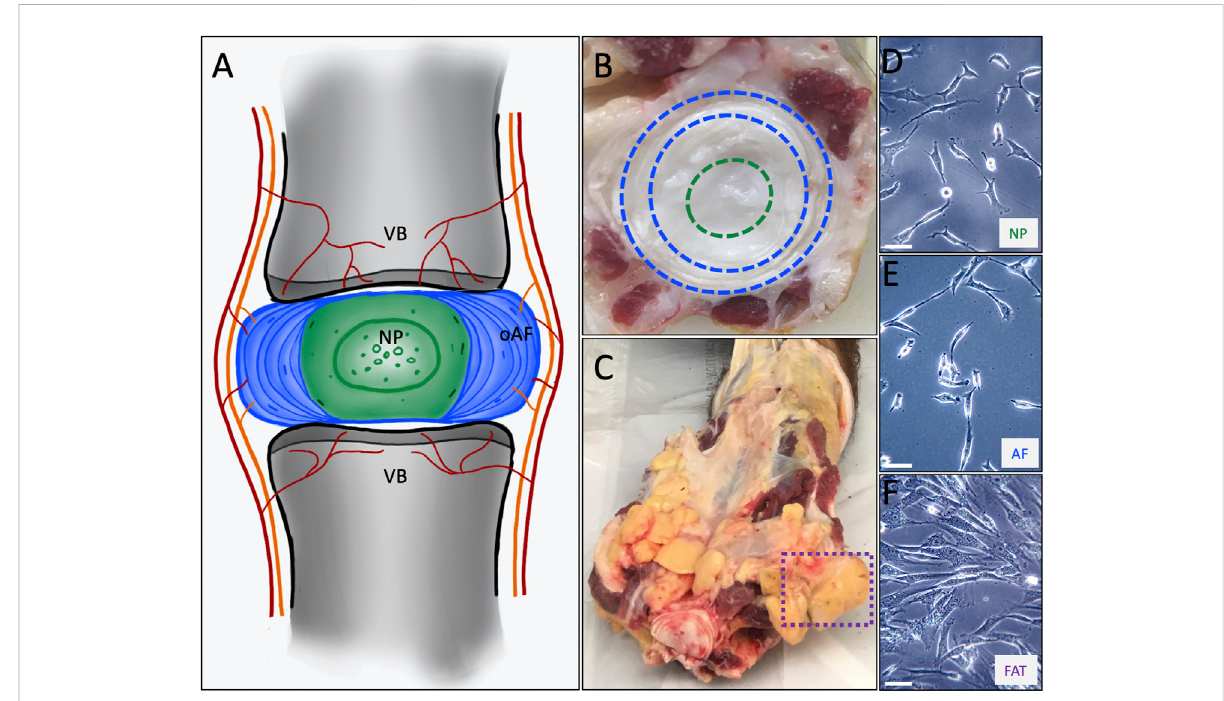
FIGURE 1 (A) Schematic representing the intervertebral disc consisting of an outer annulus fi brosus (oAF) and inner nucleus pulposus (NP) sandwiched between the cartilaginous endplates of the adjacent vertebral bodies (VB). (B) A cut through a bovine tail showing a coccygeal IVD. The outer AF as seenbetweenthebluedashedlinesandtheNPwithin thegreendashedcircle servedastissue sourceto deriveAF andNPcelllines. (C) Theboxwith thedashedpurple line showscoccygeal, subcutaneous adiposetissue used as sourceto derive FATcells. Theprimary celllines areshown atp0 as they attach to a plastic surface for NP (D) , AF (E) and FAT (F) cells. The scale bar represents 50 μ